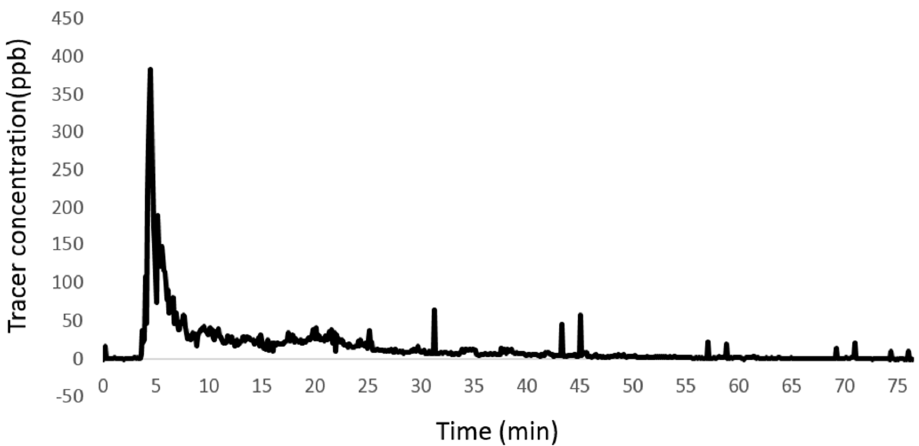
Figure 3. Tracer response curve of the flume experiment without obstructions or vegetation. Table 2. Validation of the flume model based on comparisons with the on-site investigation and mathematical model simulation with no obstructions.